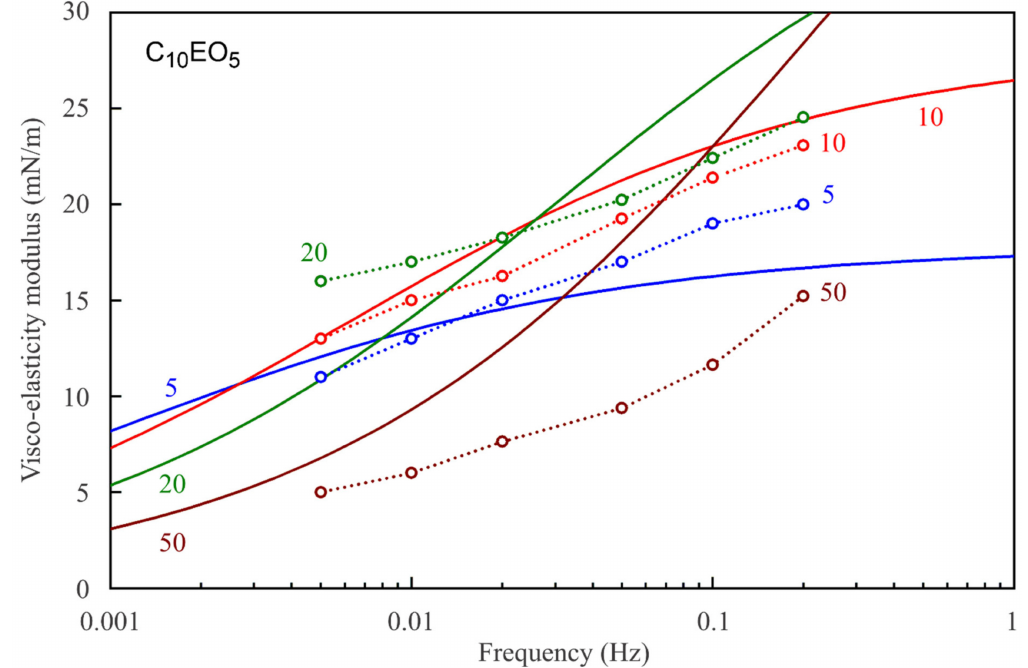
Figure 7. Experimental visco-elasticity modulus vs. frequency for C 10 EO 5 solutions of different concentrations (5, 10, 20, and 50 µ mol/L, as indicated by numbers) and the respective theoretical curves calculated with the LvT equation, Equation (8), with E 0 (c) and ω D (c) calculated for the reorientation model, Equations (1)–(6), with the parameter values presented in Table 1. Dotted lines are guides for the eye.